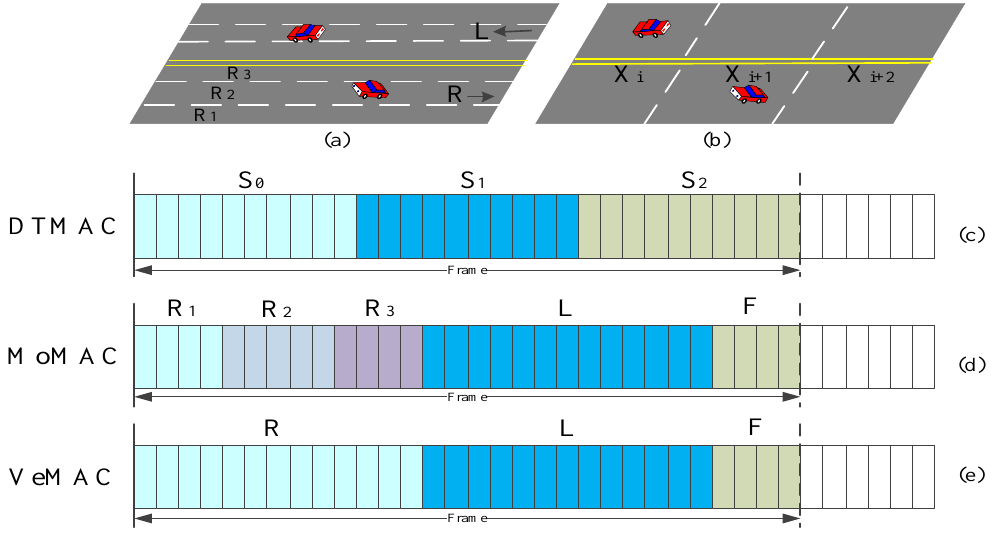
Figure 4. Time structure comparison of DTMAC, MoMAC, and VeMAC.